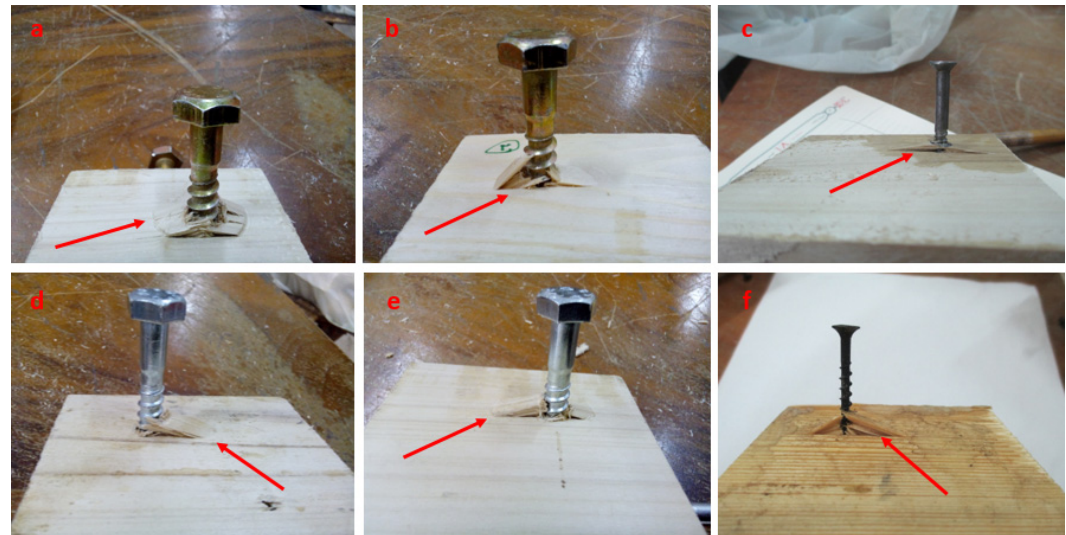
Figure 8. Typical failure modes of CLT members under the withdrawal load parallel to the grains (S direction). ( a – d ) Withdrawal failure accompanied by substantial fiber deformation. (S direction). ( a – d ) Withdrawal failure accompanied by substantial fiber